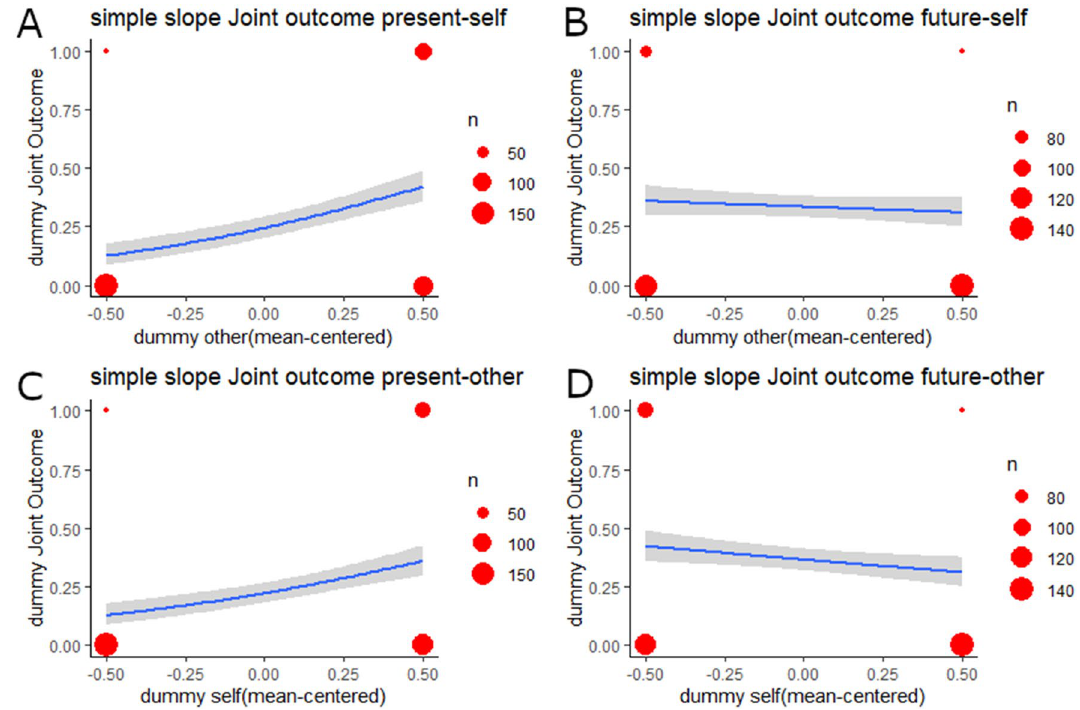
Figure 3. Results of simple slope analyses for Joint outcome preference. Size of the red dots indicates sample size. Blue lines are regression lines, and gray-colored areas indicate 95% confidence intervals. ( A ) Simple effects of other condition in the present-self condition (self dummy = 0). ( B ) Simple effects of other condition in the future-self condition (self dummy = 1). ( C ) Simple effects of self condition in the present-other condition (other dummy = 0). ( D ) Simple effects of self condition in the future-other condition (other dummy = 1). This figure was drawn using the ggplot2 package 53 (ver. 3.2.0) for